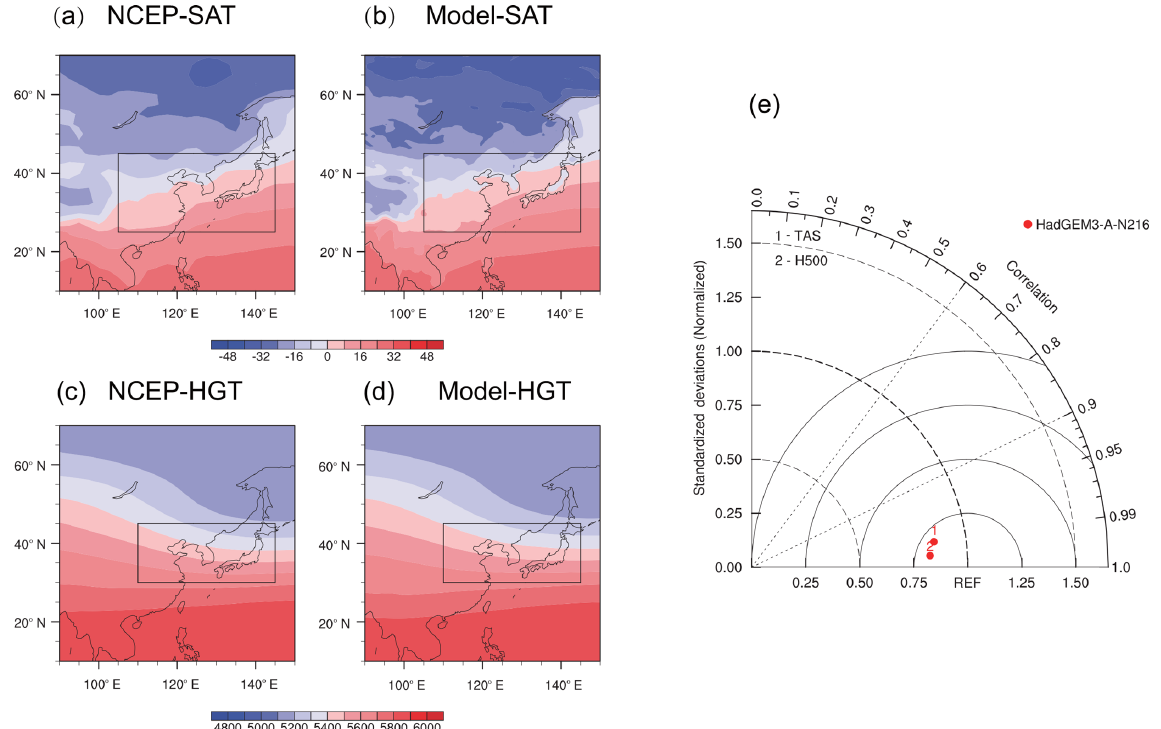
Figure 1. Climatology of winter-mean (DJF) (a) surface air temperature (shading, ◦ ) and (c) 500hPa geopotential height (shading, meters) during 1960–2012, based on NCEP reanalysis data. (b, d) As in (a) and (b) but for the model’s All-Hist runs. (e) Taylor diagram of winter- mean climatology for surface air temperature (TAS; 25–45 ◦ N, 105–145 ◦ E) and 500hPa geopotential height (H500; 25–45 ◦ N, 105–145 ◦ E). The rectangle marks the areas used to calculate the climatology in the Taylor